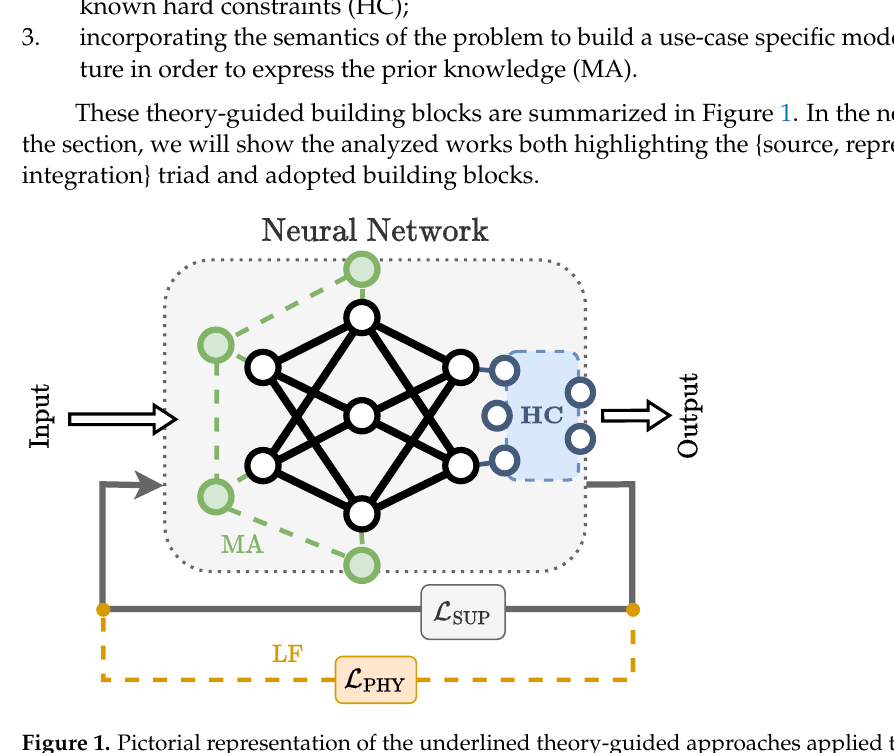
Figure 1. Pictorial representation of the underlined theory-guided approaches applied to a generic neural